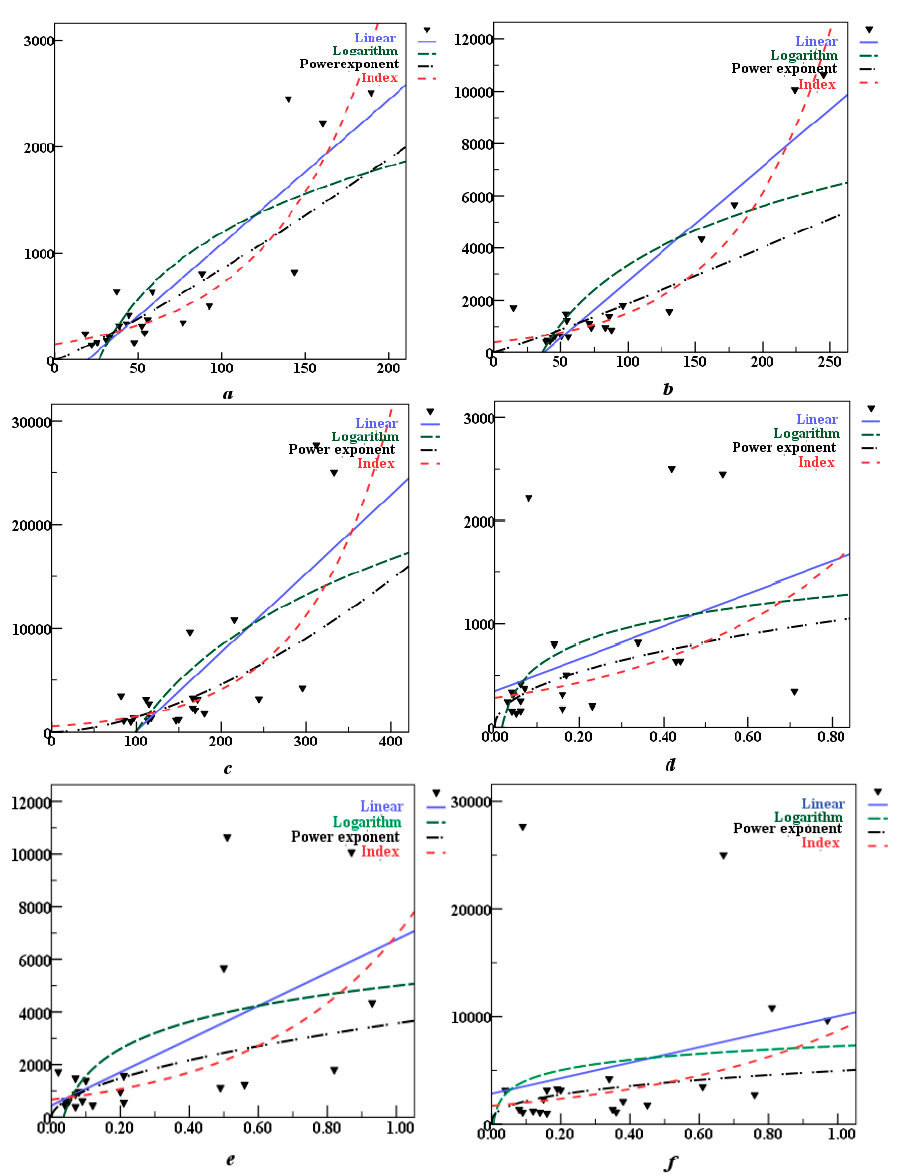
Figure 5. ( a – c ) GDP regression (100 million RMB) with TNL (10 3 ) and ( d – f ) GDP regression (100 million RMB) with I Figure 5. ( a –c) GDP regression (100 million RMB) with TNL (10 3 ) and ( d–f ) GDP regression (100 million RMB) with I.